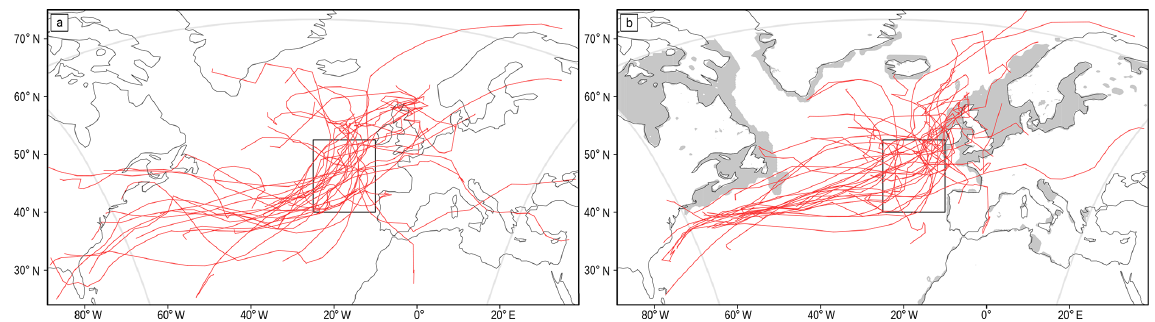
Figure 5. Cyclone tracks of top 30 (a) PI and (b) LGM cyclones (MPI-ESM). The black box indicates the region where cyclones need to have maximum intensity to be considered in the composite